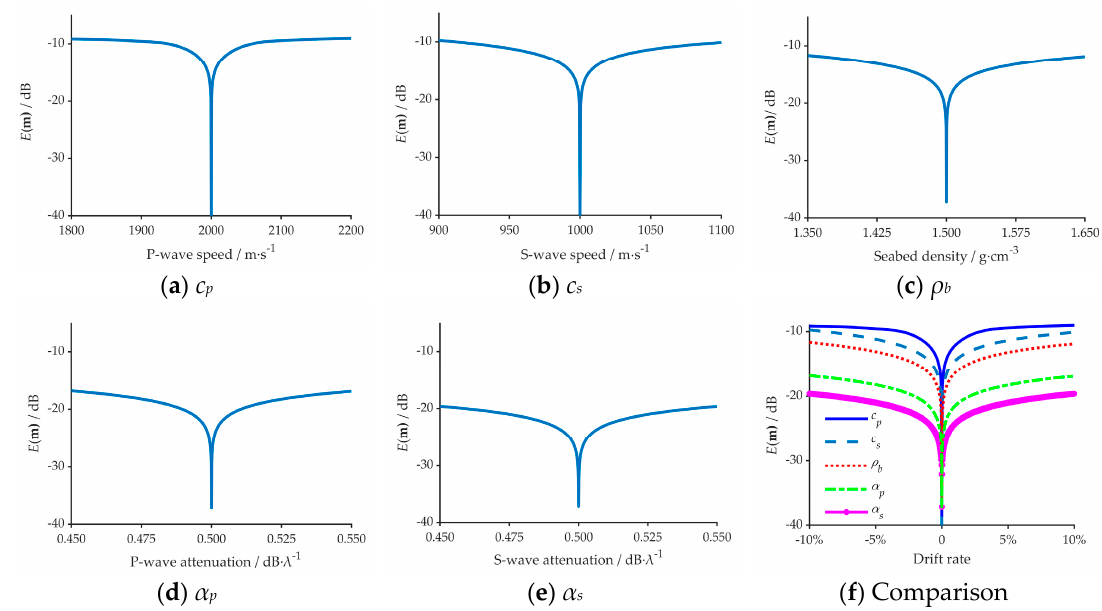
Figure 5. The sensitivity of the cost function ( E ( m )) for the five geoacoustic parameters. ( a ) to ( e )corresponds to the c p, c s, ρ b, α p , and α s , respectively. ( f ) corresponds to the comparison of five parameter’s influence on E ( m ).